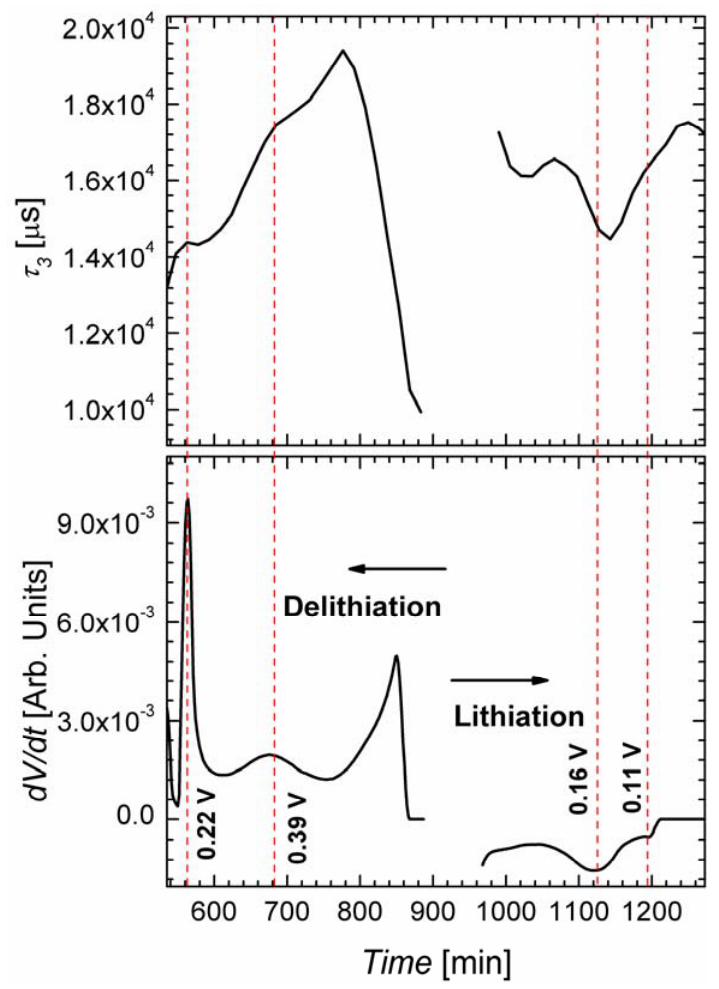
Figure 7. Plot of the time constant τ derivative of the voltage in those ranges is also